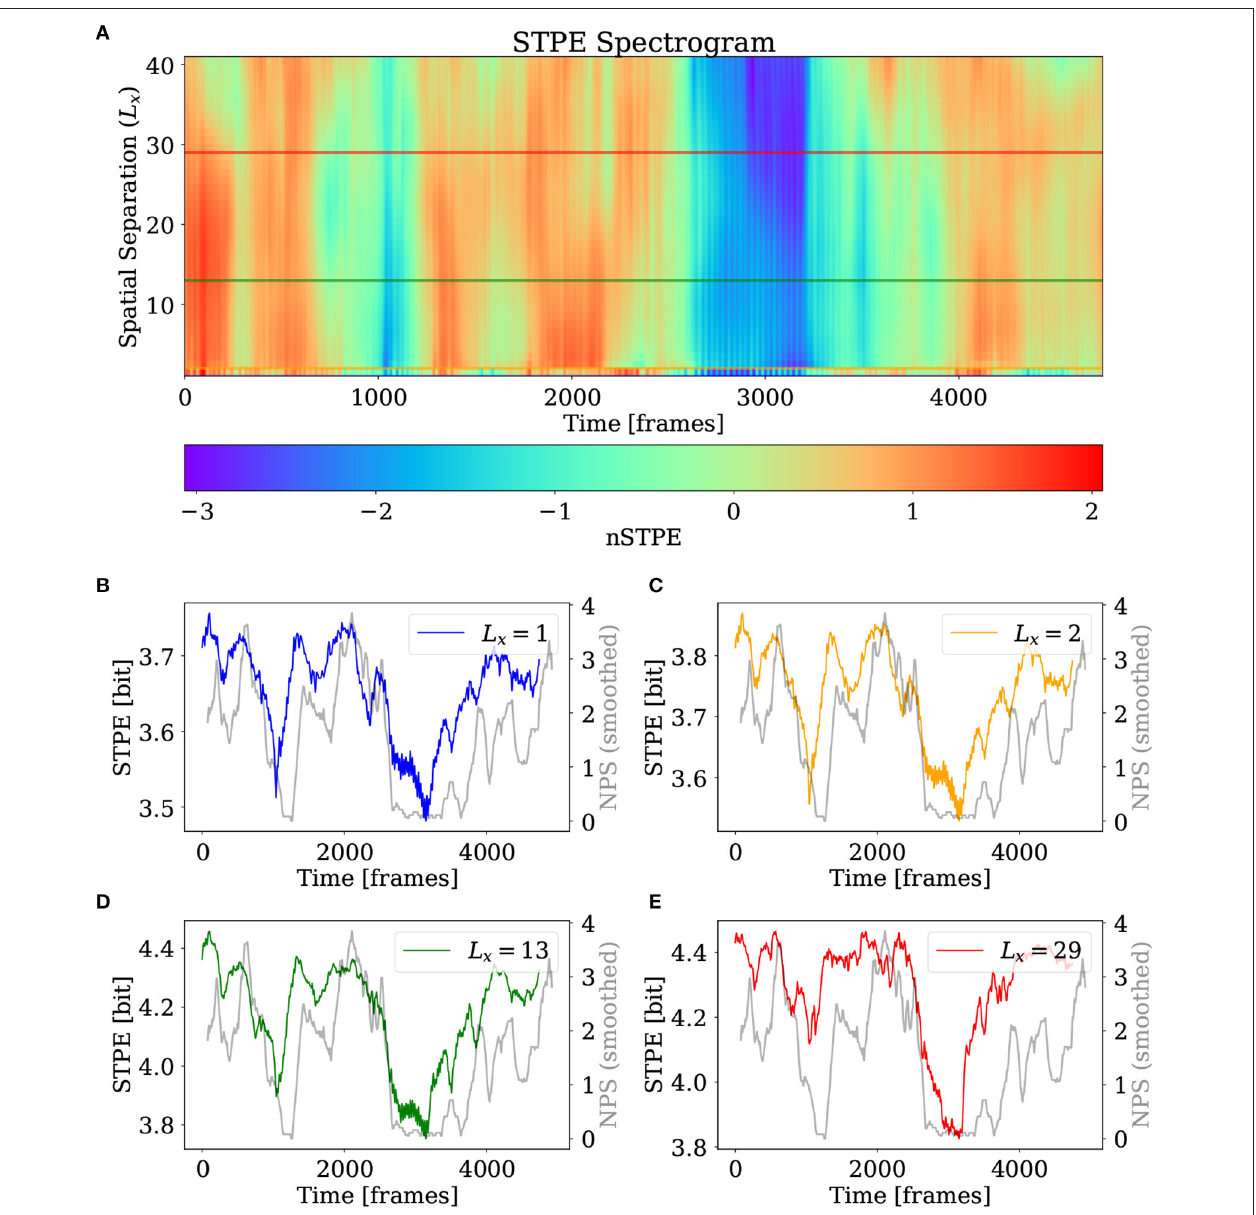
FIGURE 6 | (A) nSTPE displayed for different values of the spatial separation in a spectrogram-like view. (B–E) Show the time series for STPE at different values of the spatial separation together with NPS (gray). The values of L x are given in the subfigure legends respectively. NPS has been smoothed using a moving average filter with a width of 155